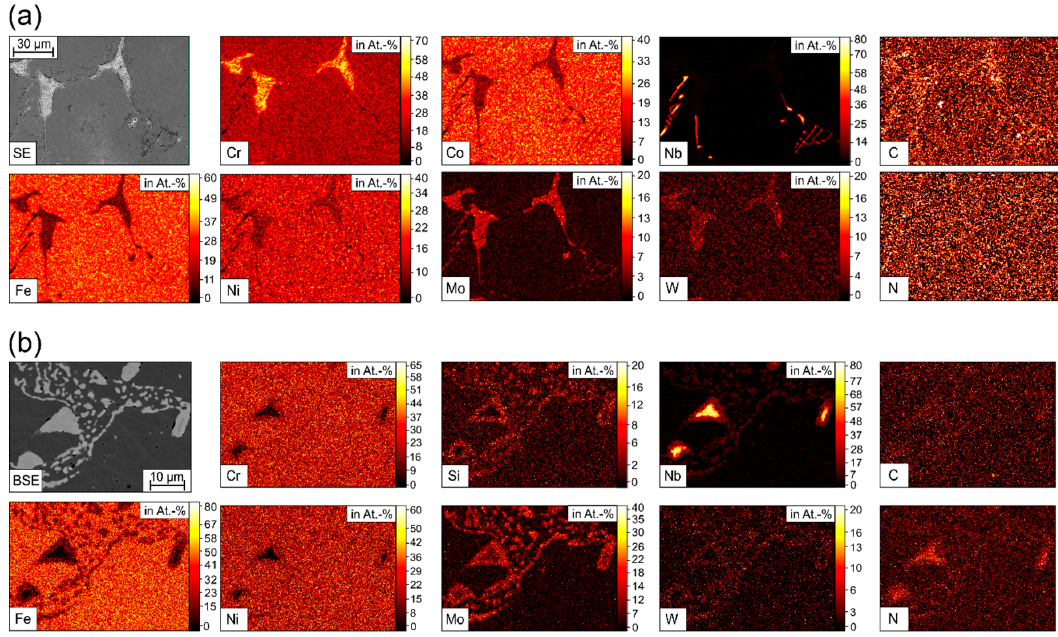
Figure 4. Local distribution of alloying elements within the steel 1.4957 ( a ) and 5Mo-2W ( b ) after solution-annealing measured via EDS.